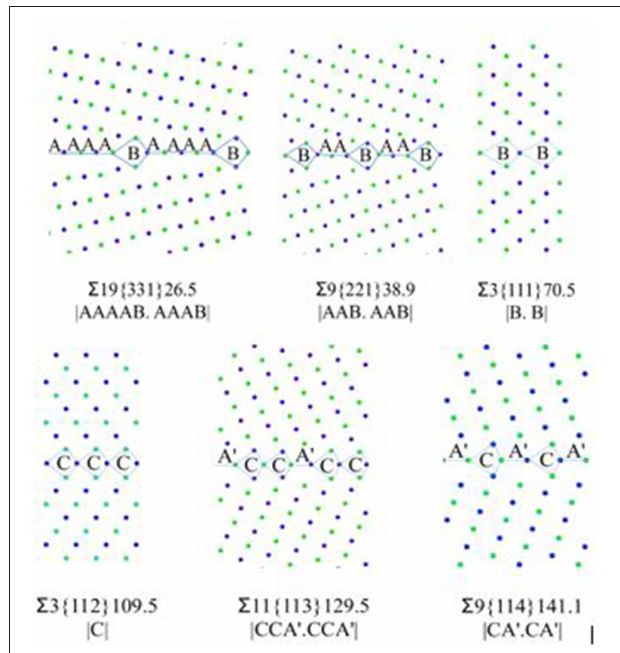
FIGURE 1 | < 110 > STGB structures with structural units notations. Green and blue colors denote atoms on different (110)